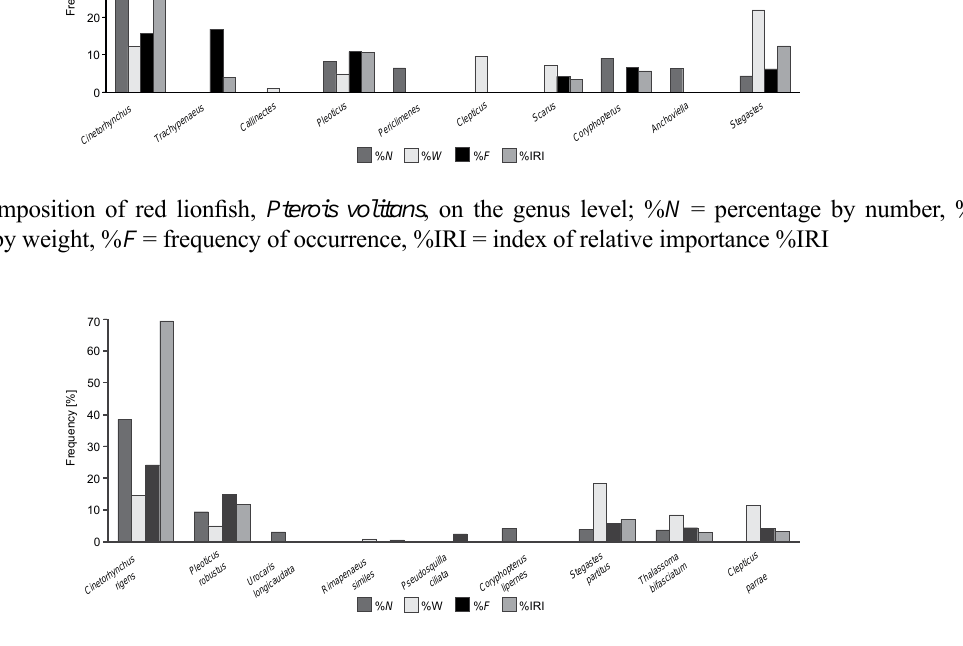
Fig. 5. Diet composition of red lionfi sh, Pterois volitans , on the species level; % N = percentage by number, % W = percentage by weight, % F = frequency of occurrence, %IRI = index of relative importance